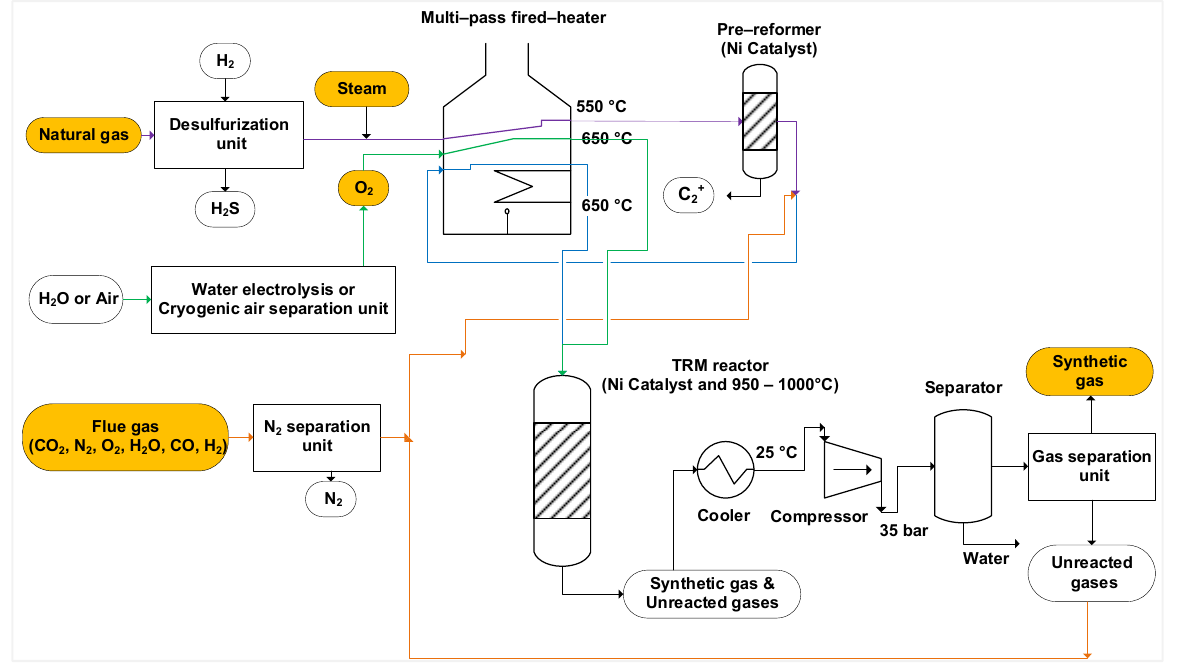
Figure 2. Process flow diagram of a tri-reforming process. Green lines: path of oxygen, purple lines: mixture of natural gas and steam, orange lines: path of flue gases or unreacted gases, blue lines: mixed streams, orange boxes: inlet and outlet gases.